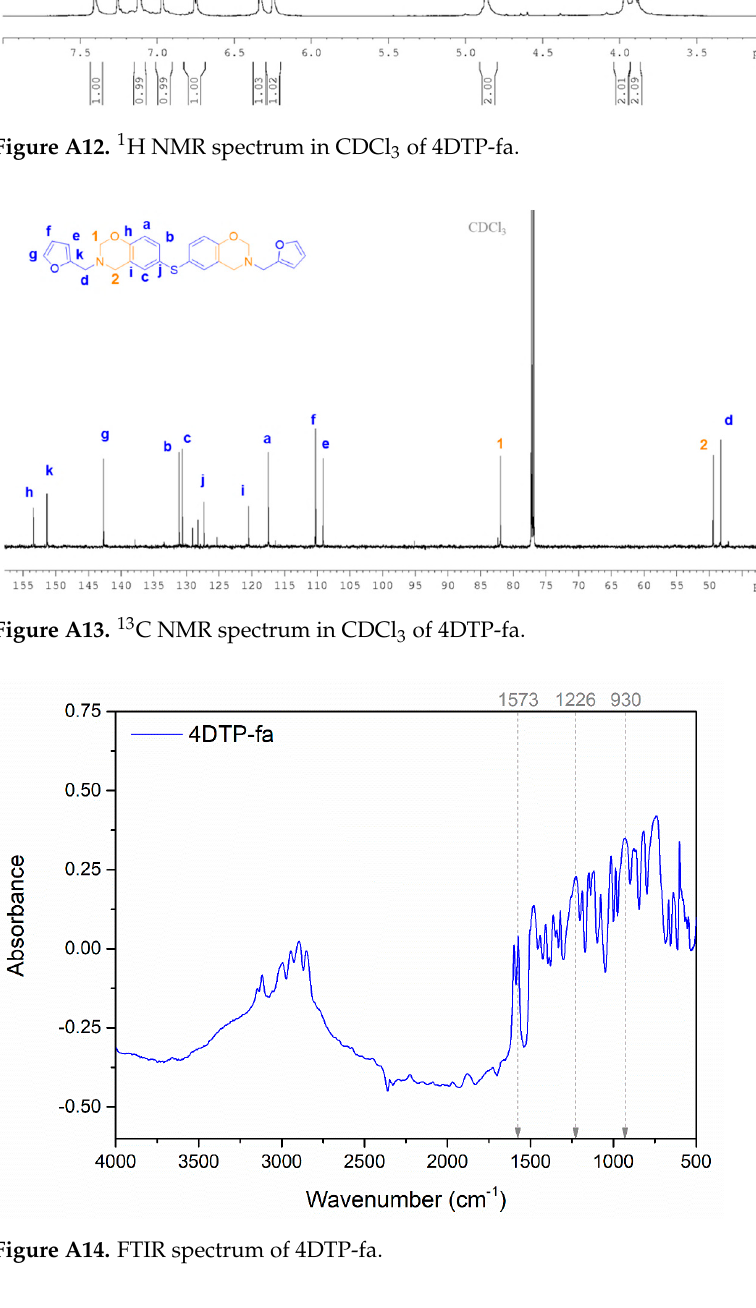
Figure A14. FTIR spectrum of 4DTP-fa.